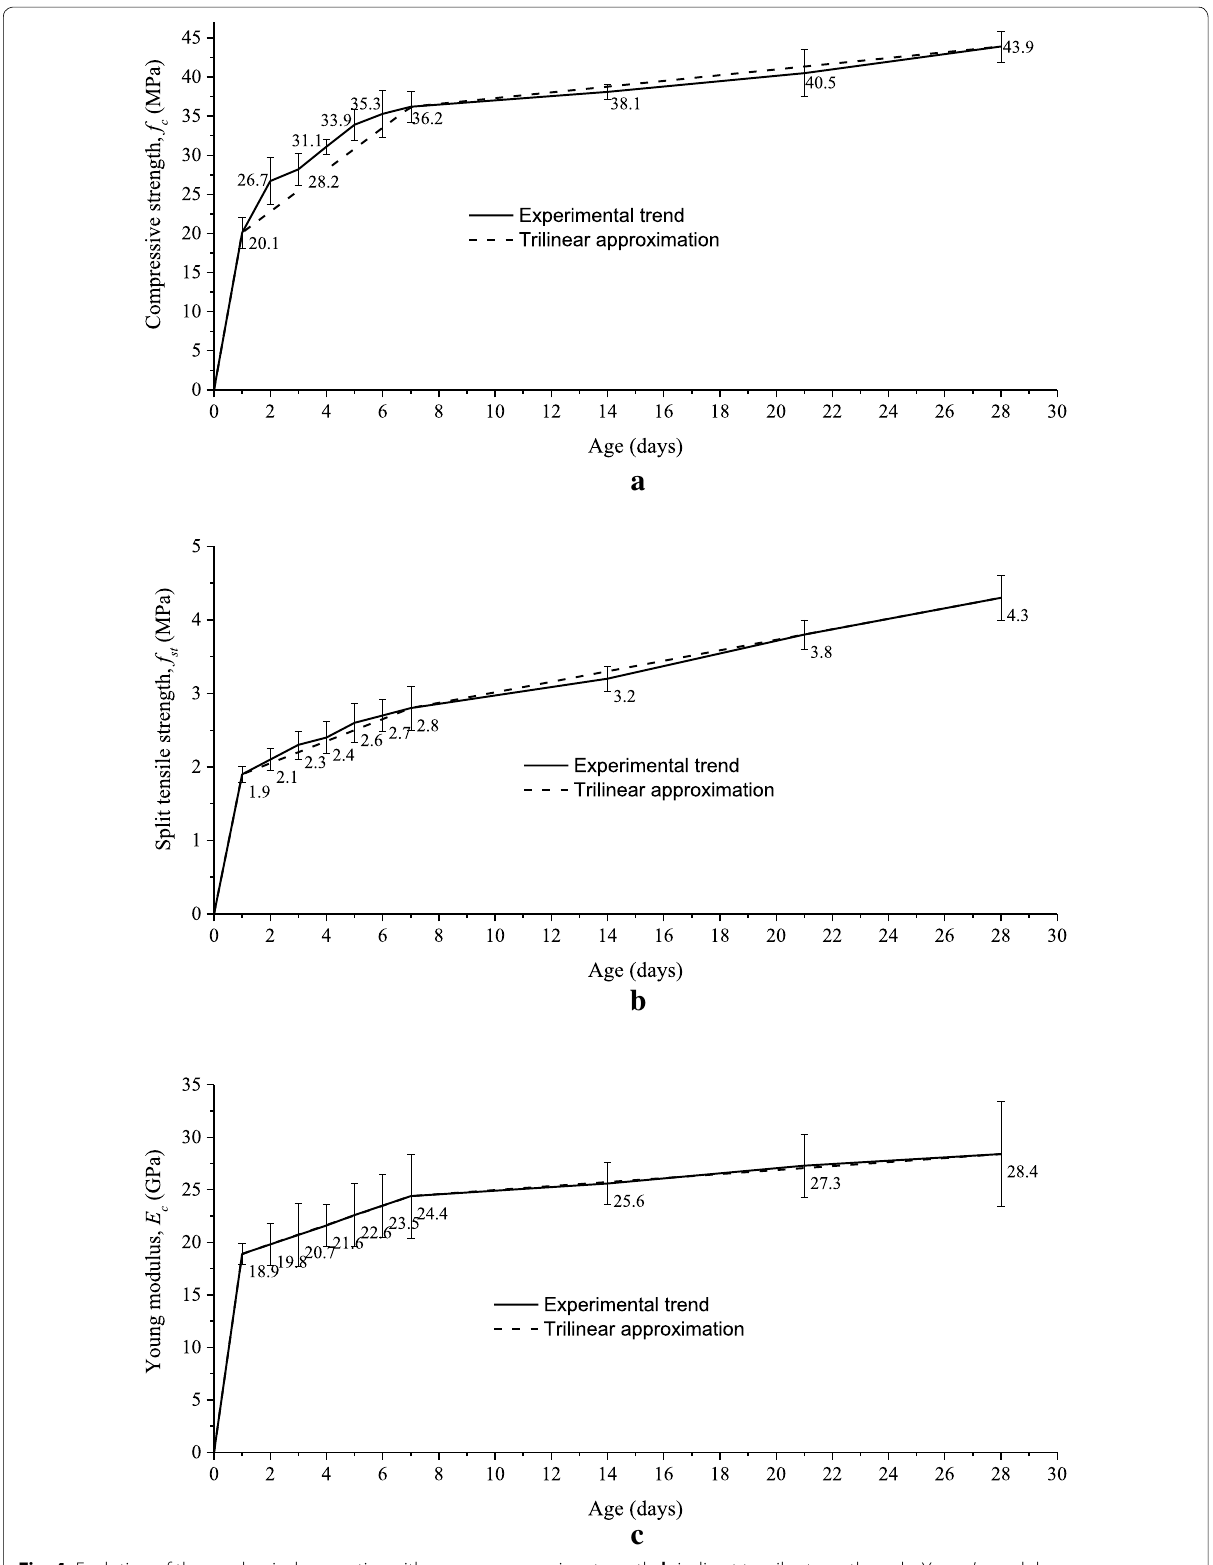
Fig. 4 Evolution of the mechanical properties with age: a compressive strength, b indirect tensile strength, and c Young’s